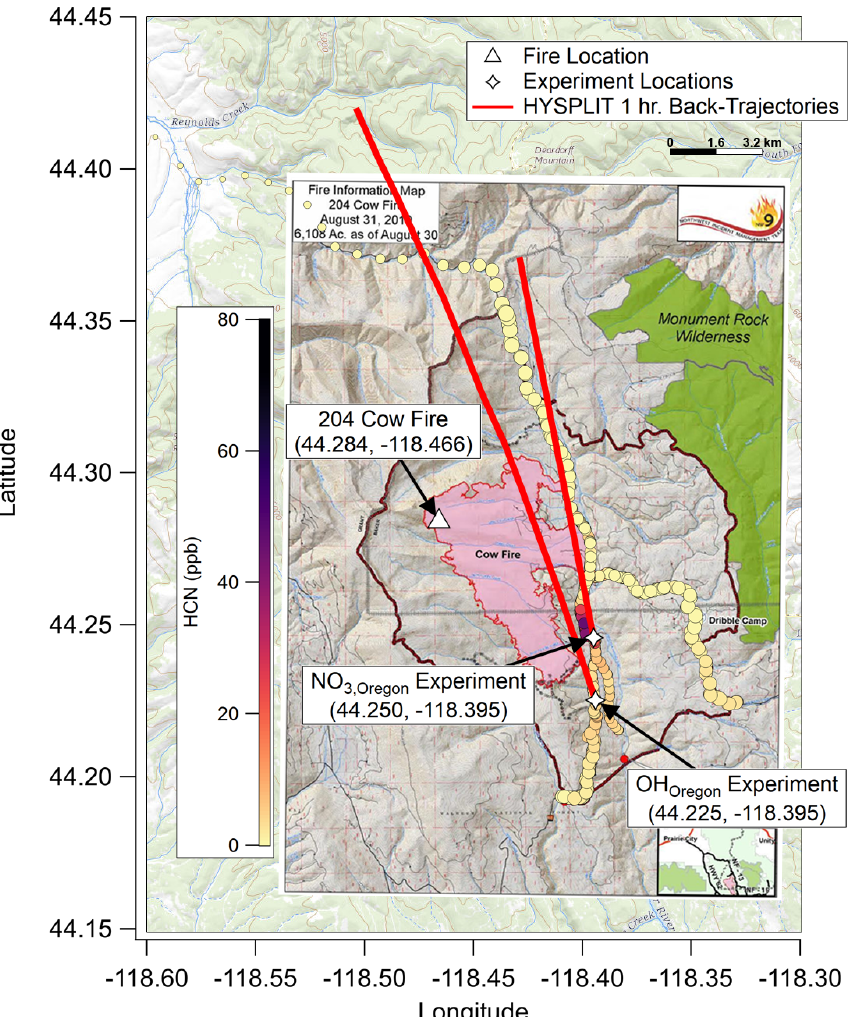
Figure 3. As with Figs. 1 and 2, showing fire ignition point (white triangle), OH Oregon and NO 3 , Oregon experiment locations (white stars), and fire boundary maps for 26 August 2019. HYSPLIT back trajectories again show that the plumes for these experiments were much less than 1h old. The background map is from USGS EarthExplorer, and fire map overlays are from the National Wildfire Coordinating Group’s Incident Information System